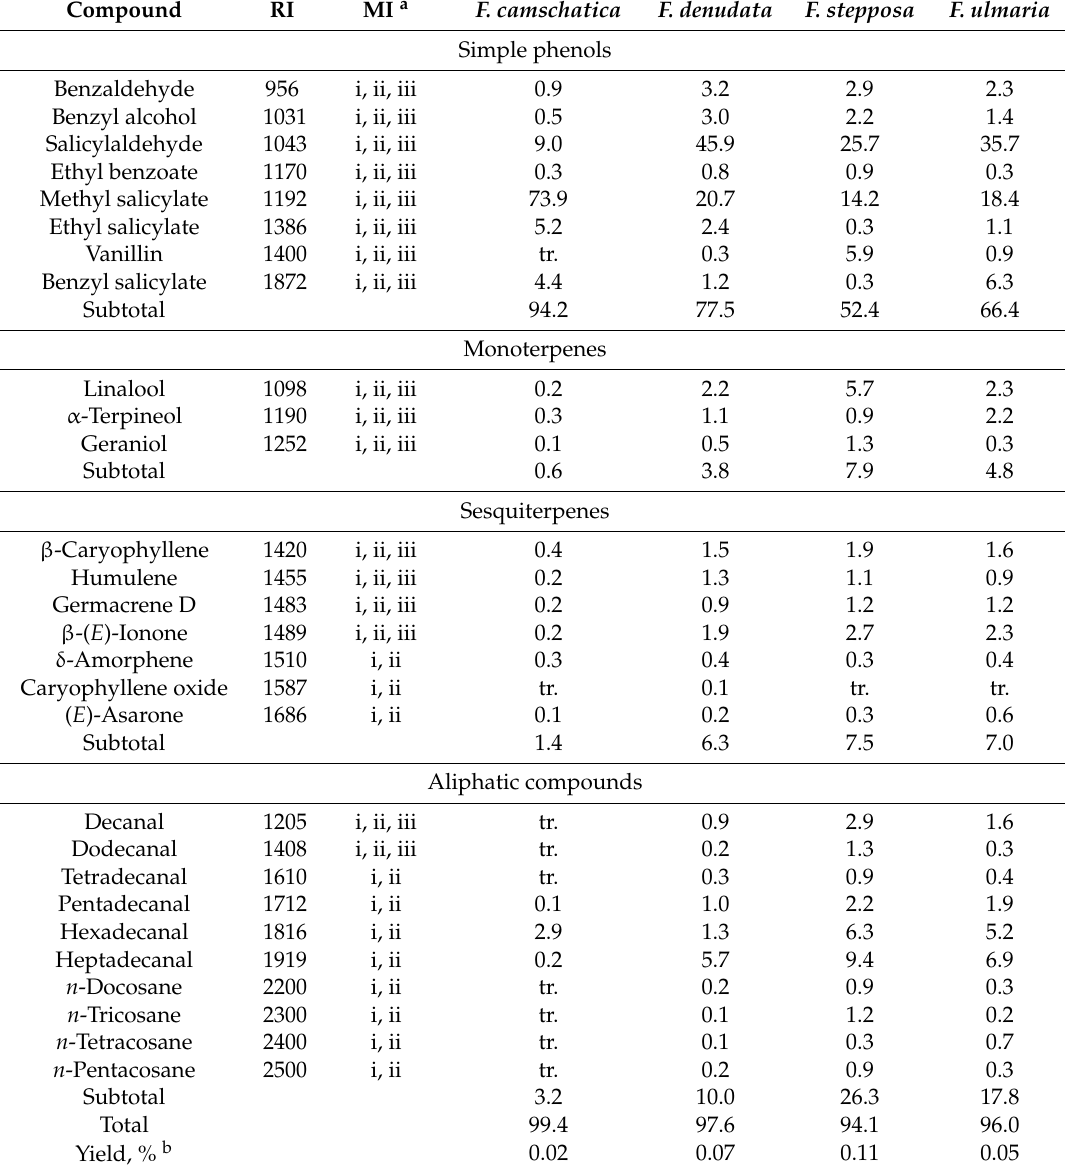
Table 4. Composition of the essential oils from the flowers of four Filipendula